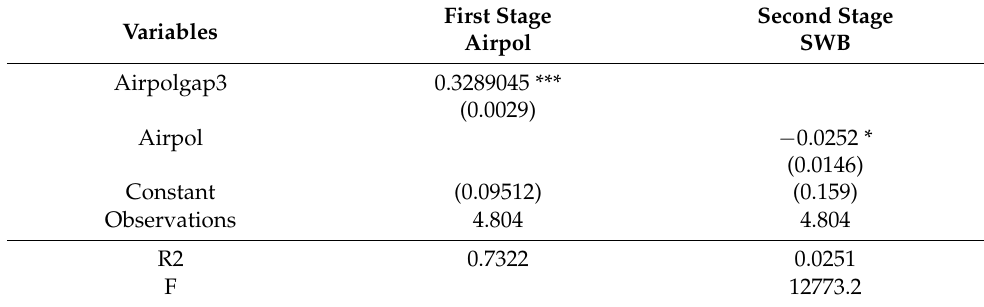
Table 10. Instrumental variable